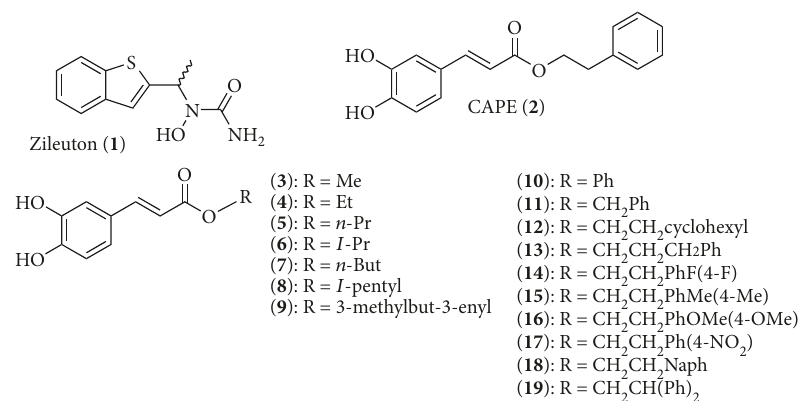
Figure 1: Zileuton ( 1 ), CAPE ( 2 ), and CAPE analogues investigated in the present